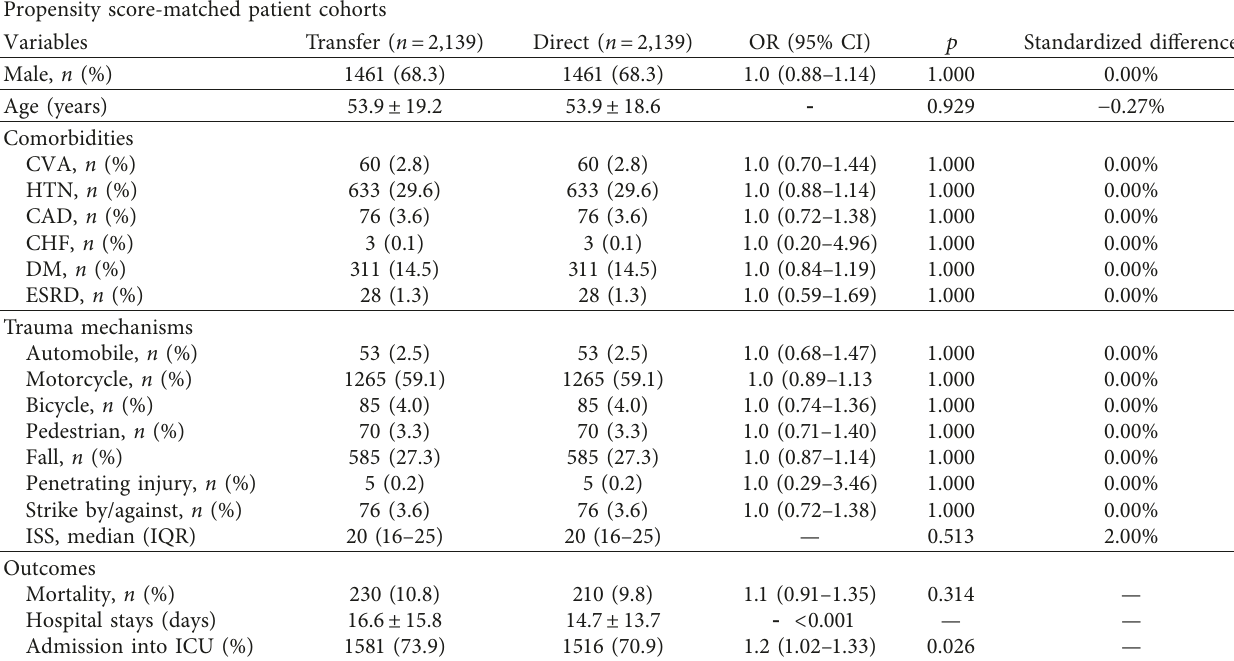
Table 2: Physiology and procedures performed at the emergency room in trauma patients with injury severity score equal to or more than 16.